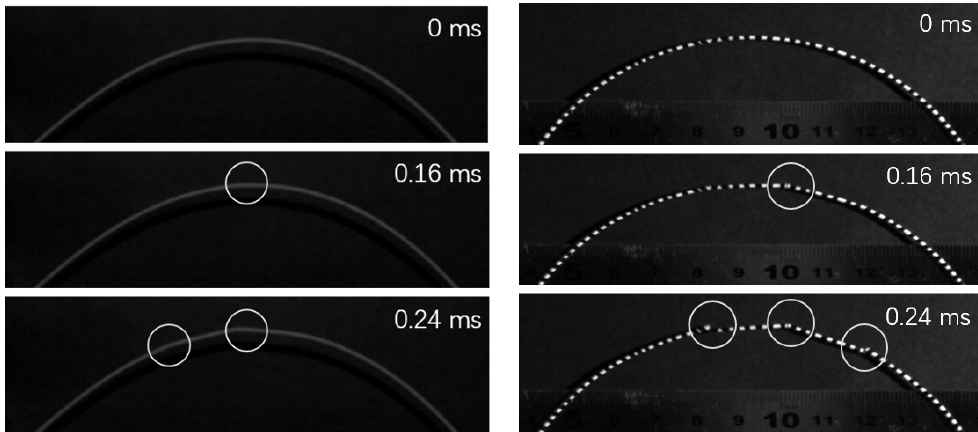
Figure 11. Experimental process of spaghetti break